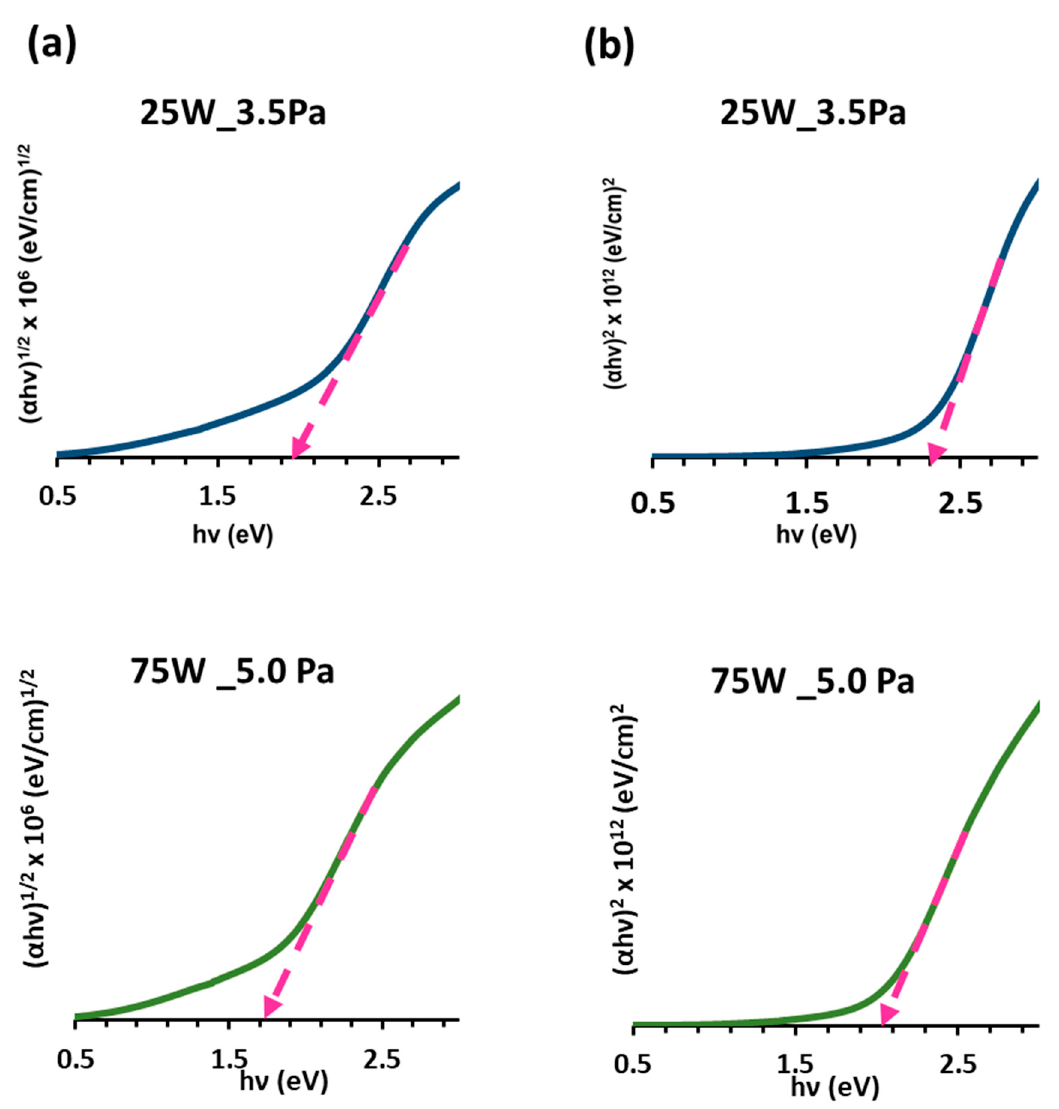
Figure 9. Plot of (cid:4666)ℎ(cid:2021)(cid:2009)(cid:4667) (cid:2869)/(cid:2870) and (cid:4666)ℎ(cid:2021)(cid:2009)(cid:4667) (cid:2870) vs. ℎ(cid:2021) for the optimized samples deposited at ( a ) 25W and Figure 9. Plot of ( h να ) 1/2 and ( h να ) 2 vs. h ν for the optimized samples deposited at ( a ) 25 W and 3.5Pa, and ( b ) 75 W and 5.0Pa. 3.5 Pa, and ( b ) 75 W and 5.0